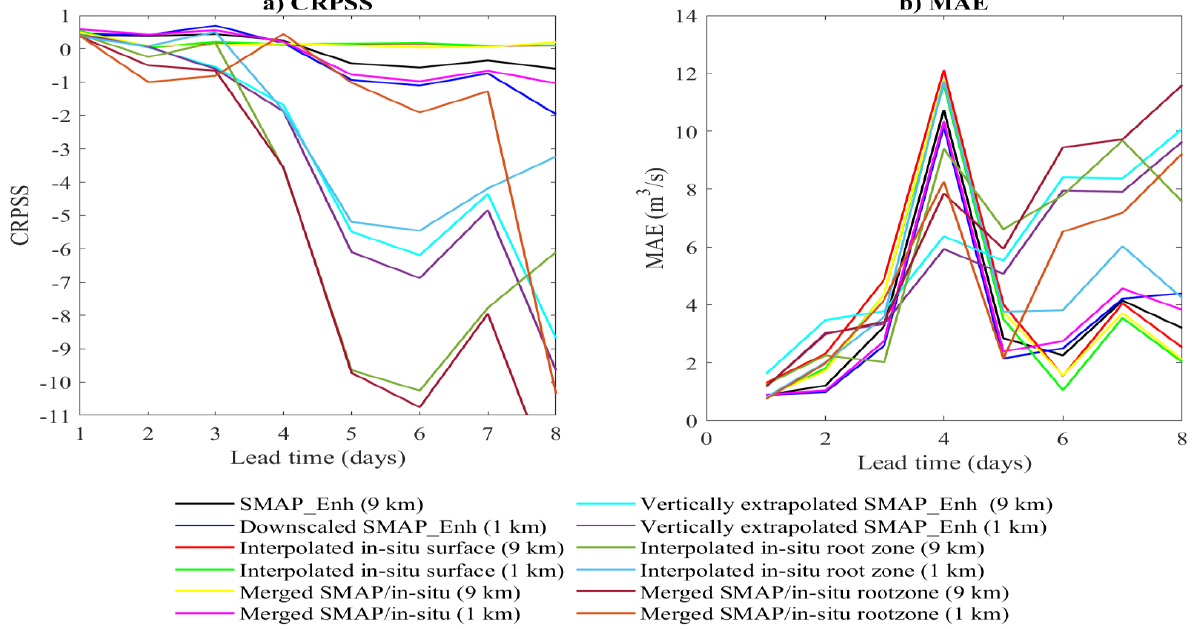
Figure 11. Variation of ( a ) mean CRPSS and ( b ) MAE with respect to lead time for ensemble and deterministic forecast, respectively.